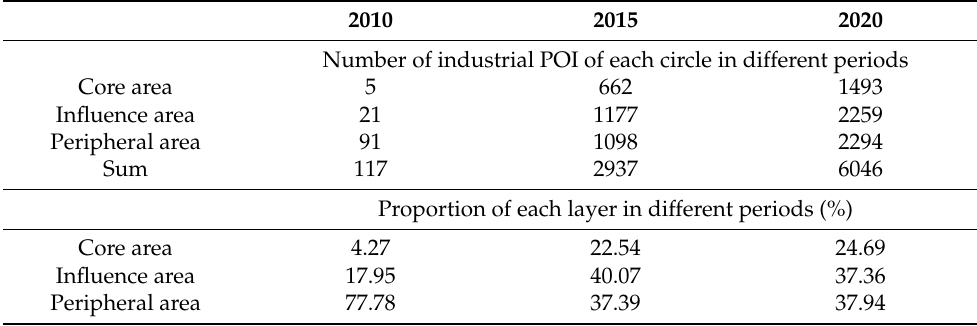
Table 2. Industrial distribution of three circles before and after the opening of HSR.